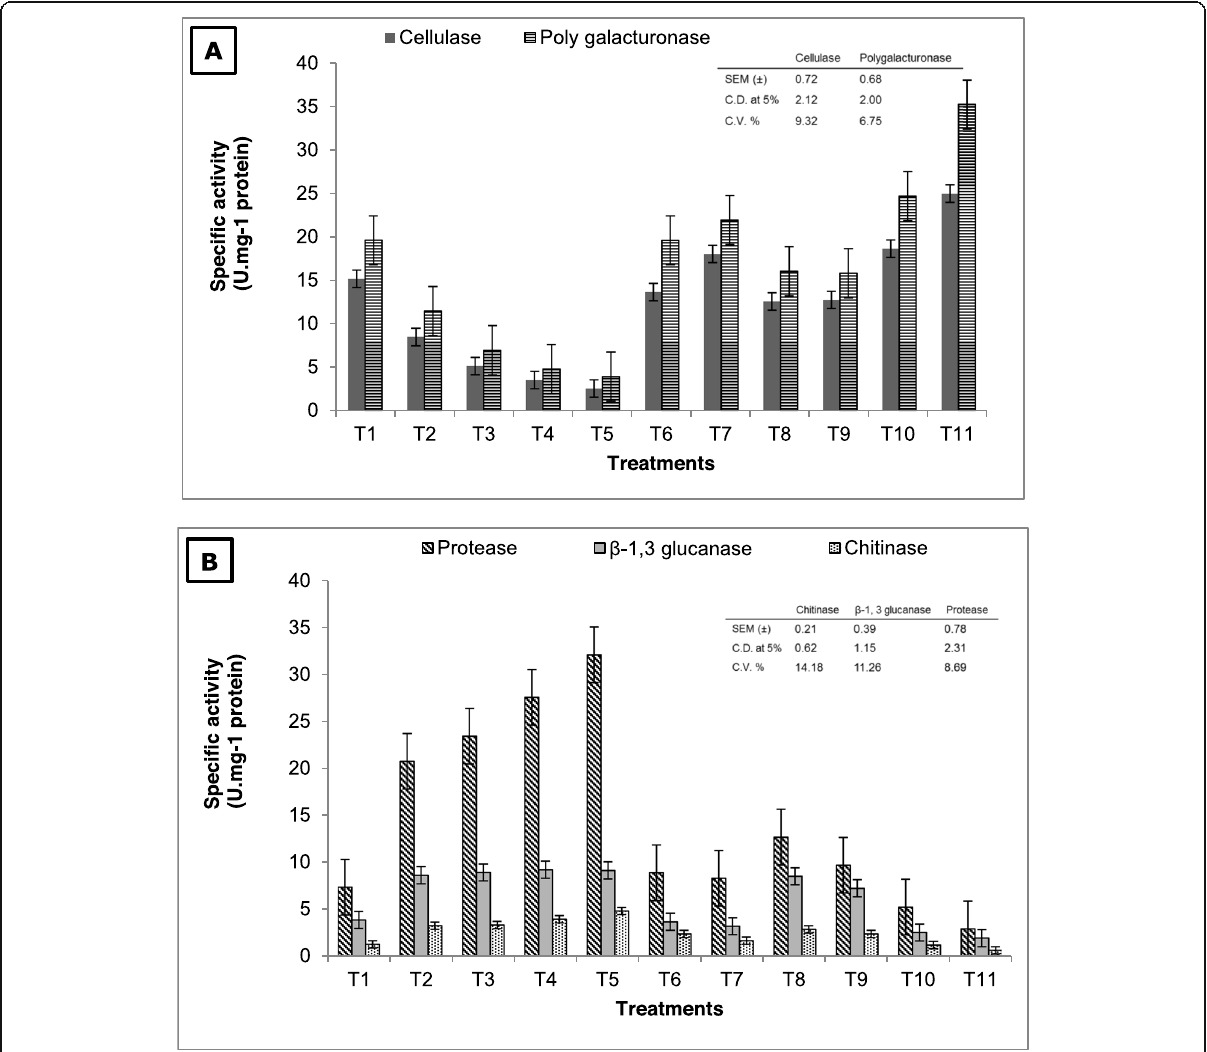
Fig. 3 In vitro production of a cell wall degrading enzymes and b pathogenesis-related enzymes in the culture medium at 6 days after inoculation (DAI). (T1 = Pf -1 × Foc ; T2 = Pf -2 × Foc ; T3 = Pf -3 × Foc ; T4 = Pf -4 × Foc ; T5 = Pf -5 × Foc ; T6 = Pf -6 × Foc ; T7 = Pf -7 × Foc ; T8 = Pf -8 × Foc ; T9 = Pf -9 × Foc ; T10 = Pf -10 × Foc ; T11 = Control − Foc